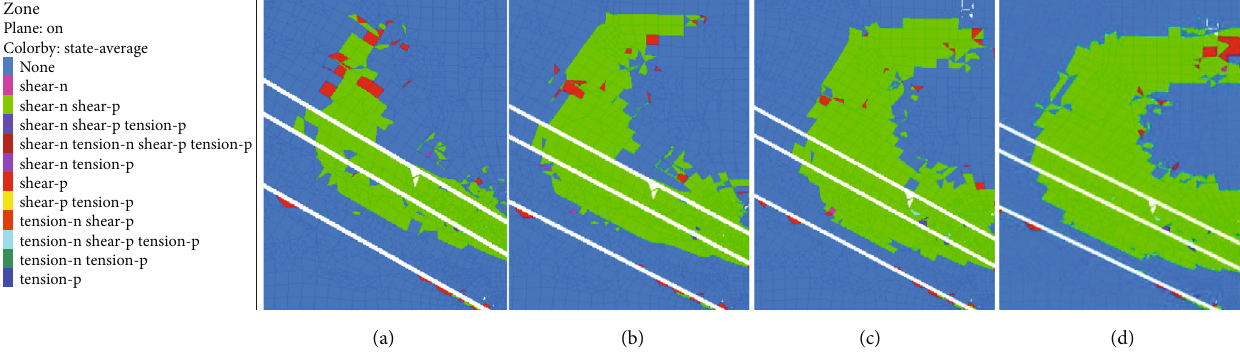
Figure 21: The change of plastic zone in two sides of roadway in 302 mining area when the cutting position is 380m ahead of schedule. (a) Working face advancing 40m; (b) working face advancing 80 m; (c) working face advancing 120m; (d) working face advancing 160 m.